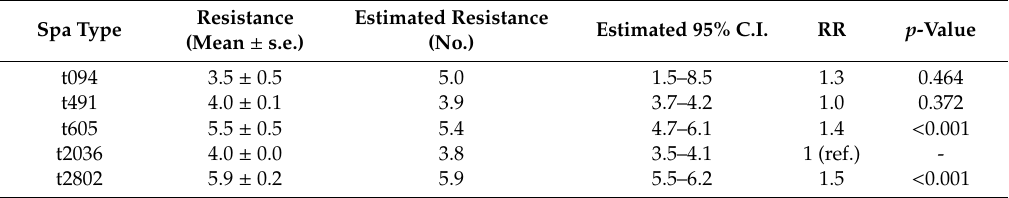
Table 4. Observed and estimated resistance types for each spa type. Relative risks of gaining one more type(s) of resistance in each group compared to